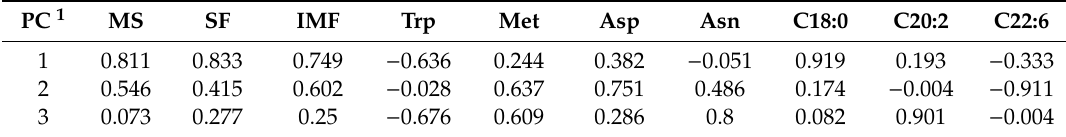
Figure 4. Results of the factor analysis. ( A ) A crushed stone graph. ( B ) A comprehensive score for factor analysis. Table 6. Rotated component